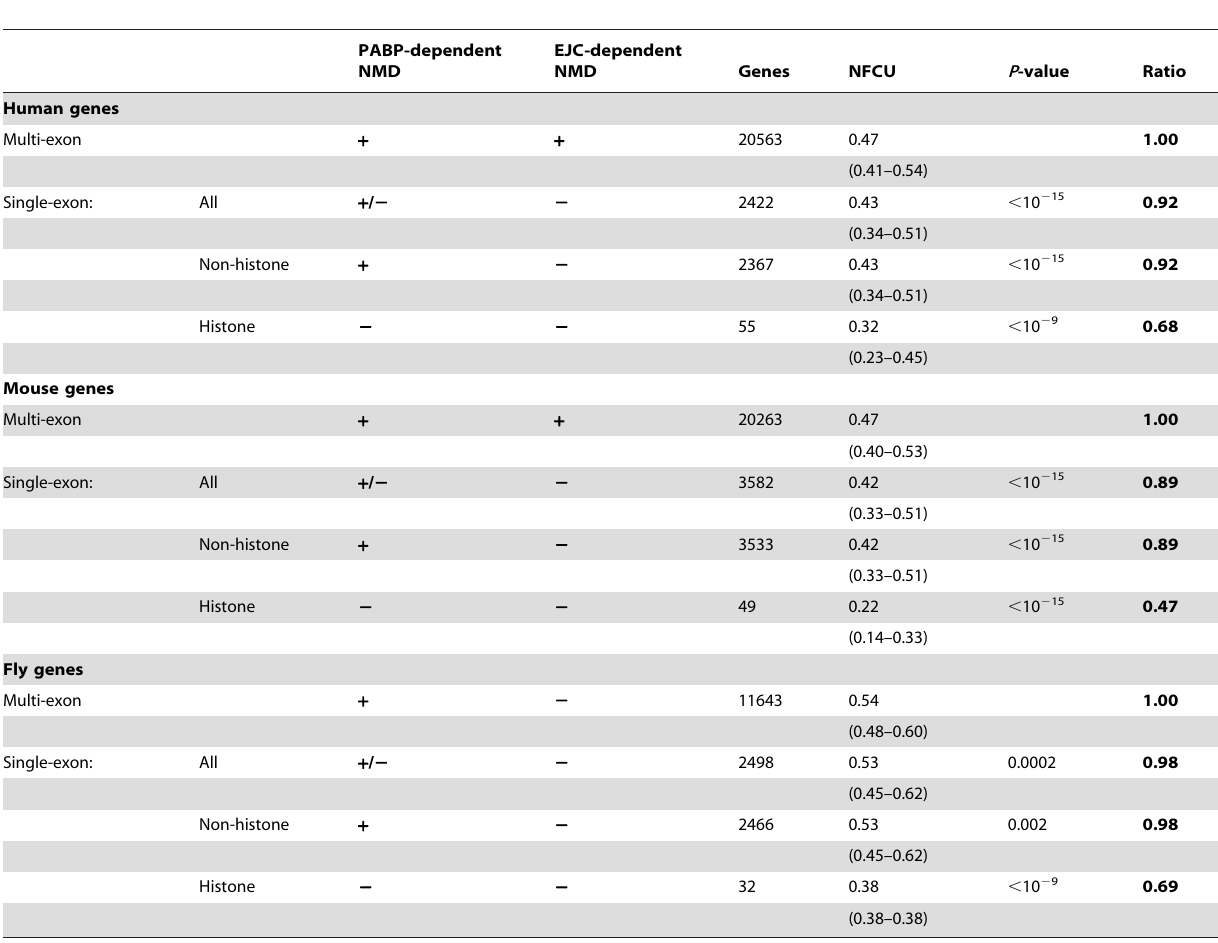
Table 1. Normalized fragile codon content (NFCU) (controlling for GC-content and amino-acid usage) of multi-exon genes and single-exon genes in the human, mouse, and fly